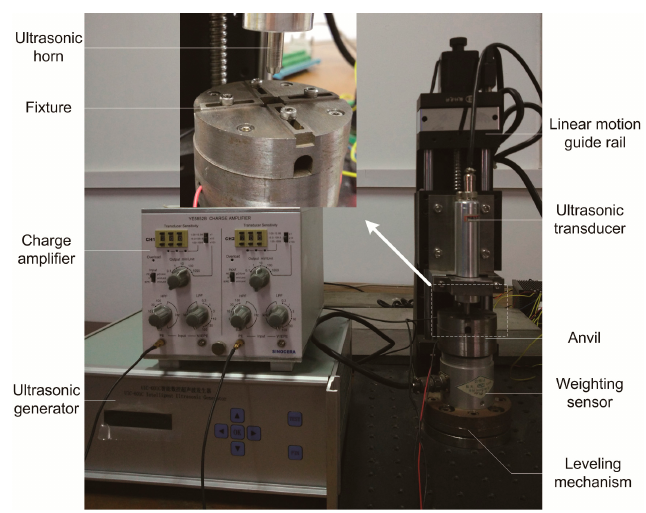
Figure 6. Ultrasonic bonding test bench.